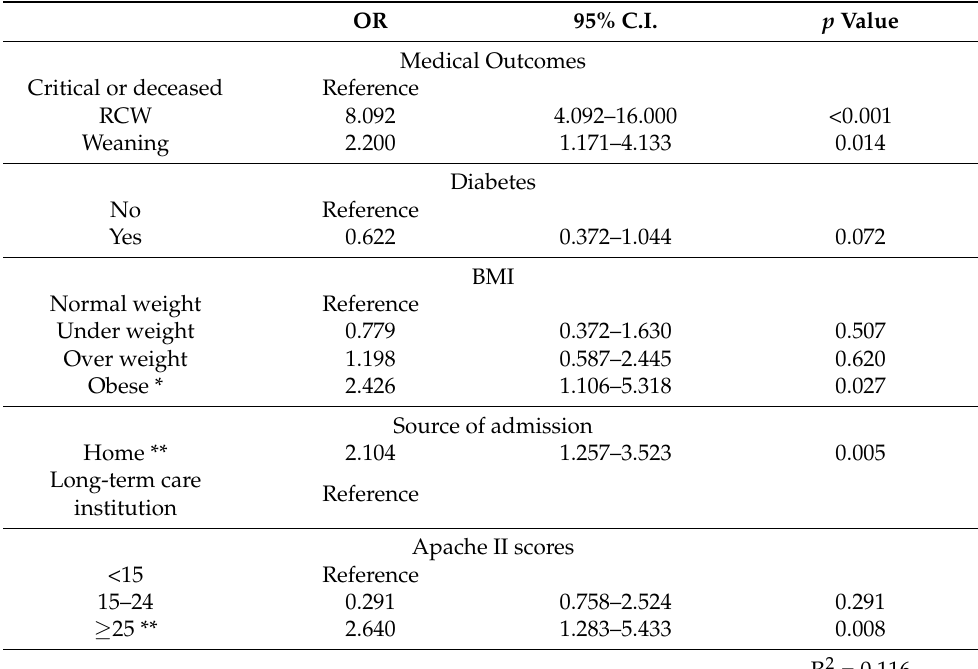
Table 3. The ordinal logistic regression analysis of medical outcomes of patients in the